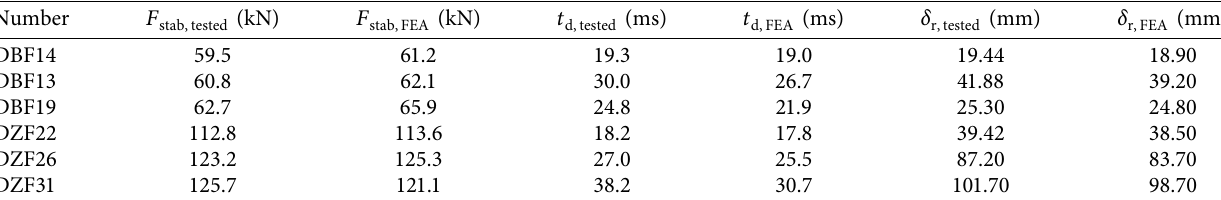
Table 2: Comparisons between the simulation and test results.